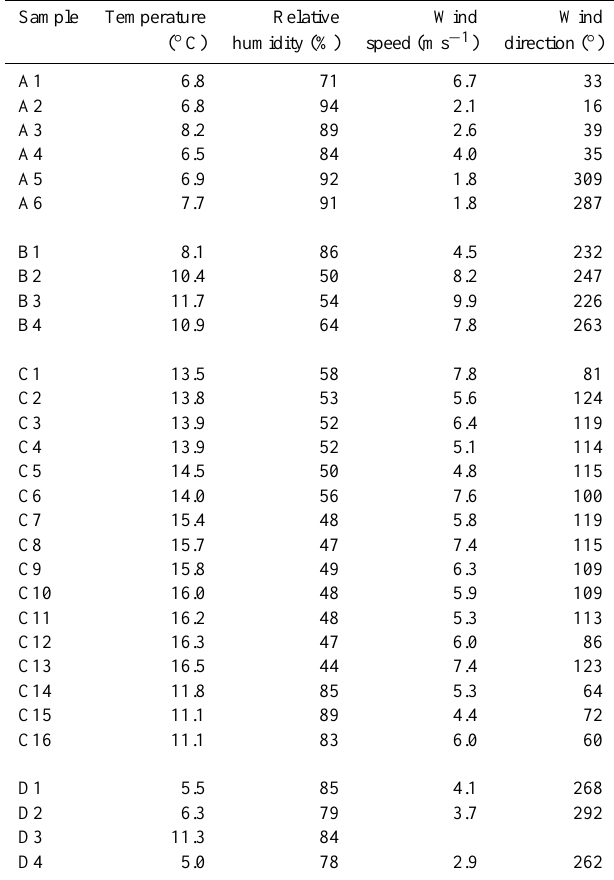
Table 2. Basic meteorological metadata for the samples discussed in this paper; the data represent averages of the corresponding vari- ables over the sampling